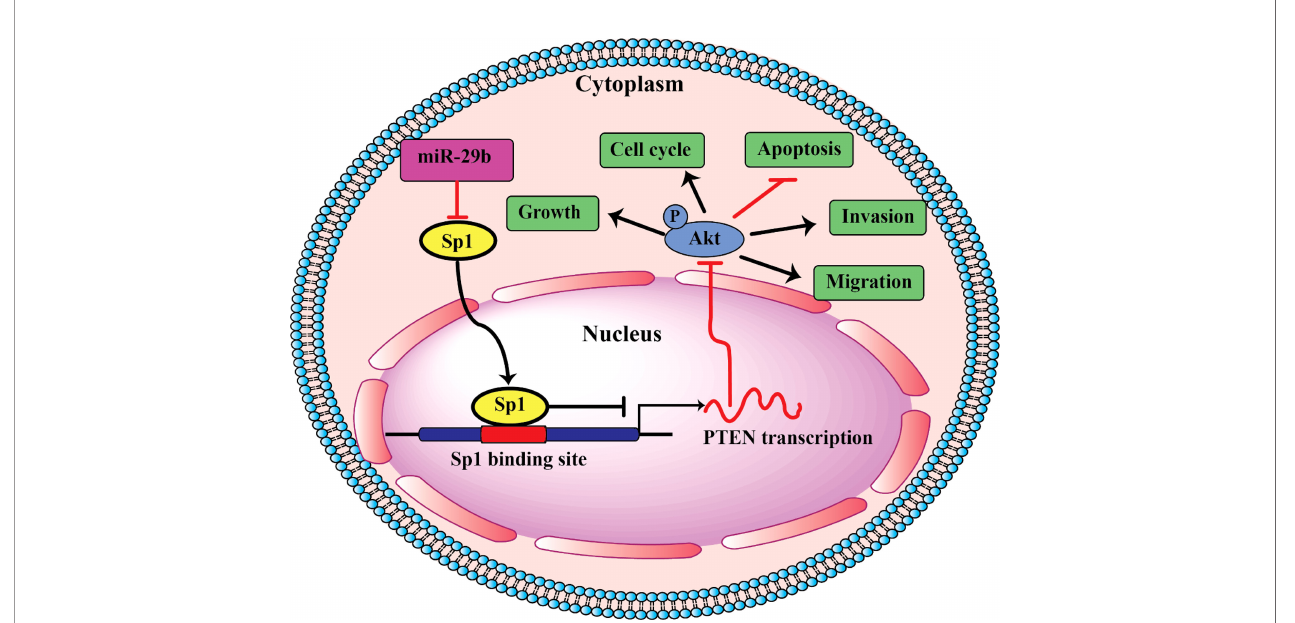
FIGURE 1 | Schematic of pathways involved in the tumor-suppressor role of miR-29b in TSCC